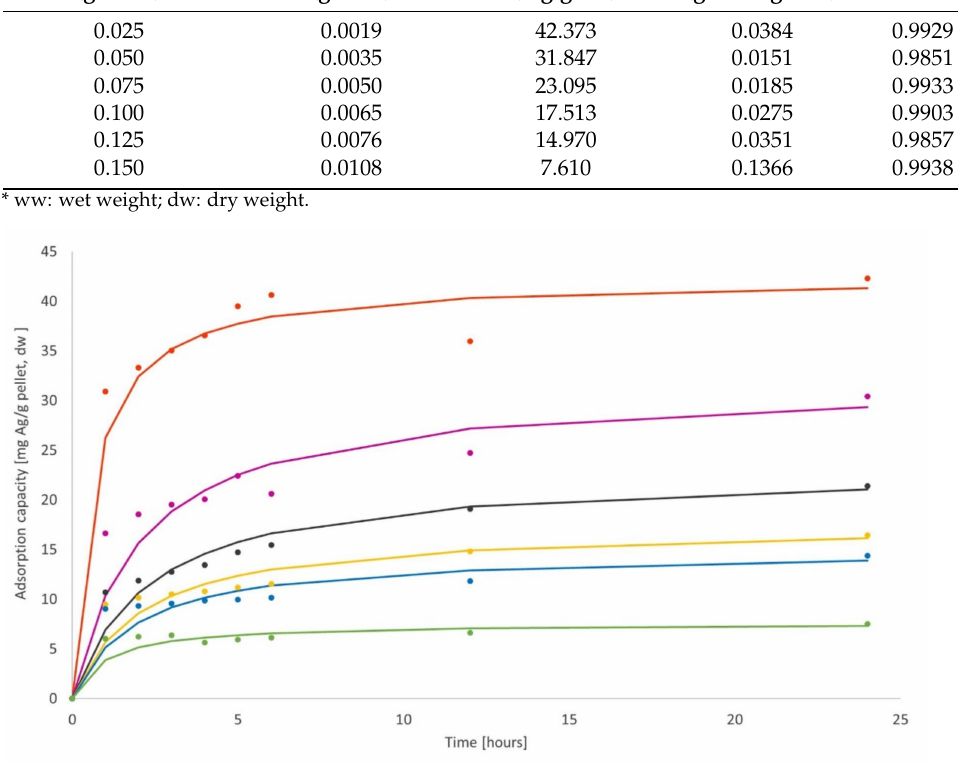
Figure 11. Ag adsorbed on different quantities (dry weight) of Aspergillus tabacinus pellets. • : 0.0019 g; • : 0.0035 g; • : 0.0050 g; • : 0.0065 g; • : 0.0076 g; • : 0.0108 g. Symbols represent experimental data, while continuous lines represent simulation results of the adjusted pseudo-second-order